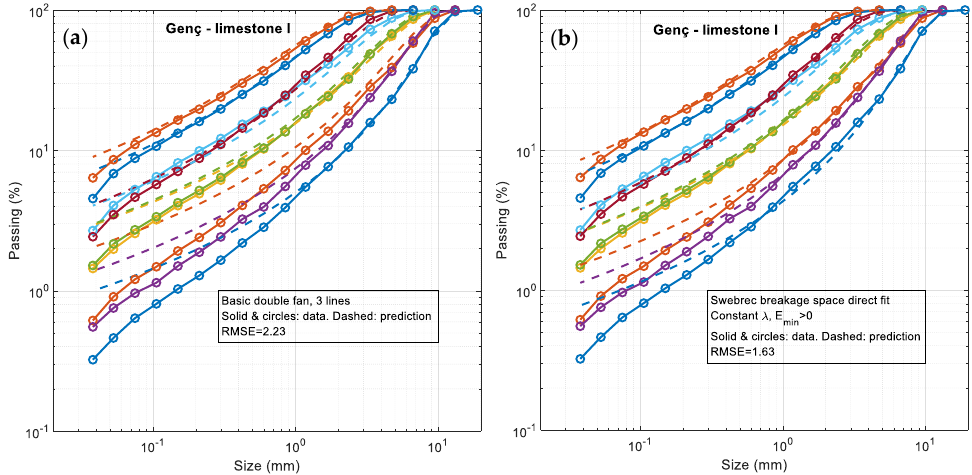
Figure 14. Assessment of the model replication of the raw size distribution data. ( a ) basic double fan fit. ( b ) direct Swebrec fit. Genç’s et al. [24] limestone I.